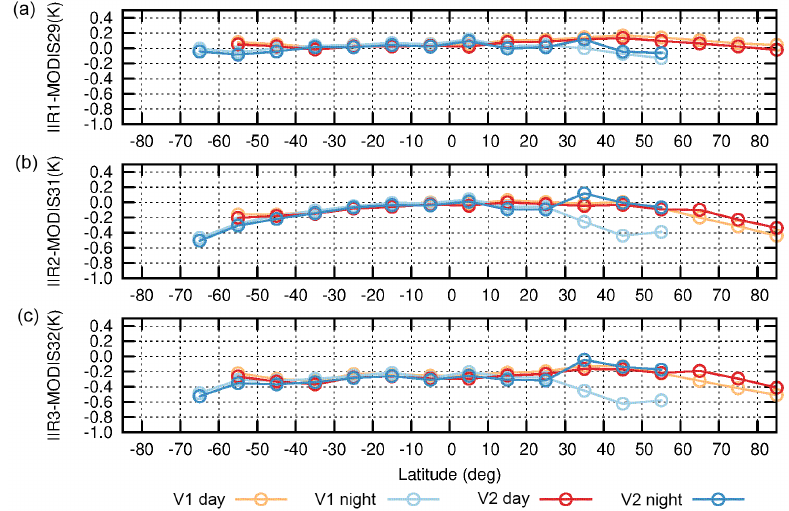
Figure 15. Difference between IIR and MODIS C5 residuals from the stand-alone approach over oceans for IIR Version 1 (orange: day; light blue: night) and Version 2 (red: day; dark blue: night) in July 2008. (a) IIR1–MODIS29; (b) IIR2–MODIS31; (c) IIR3–MODIS32.